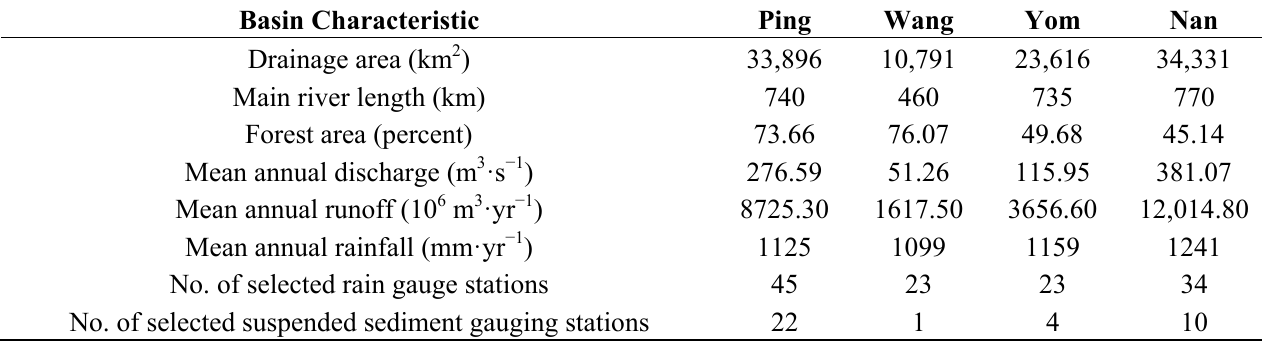
Table 1. A general description of the study